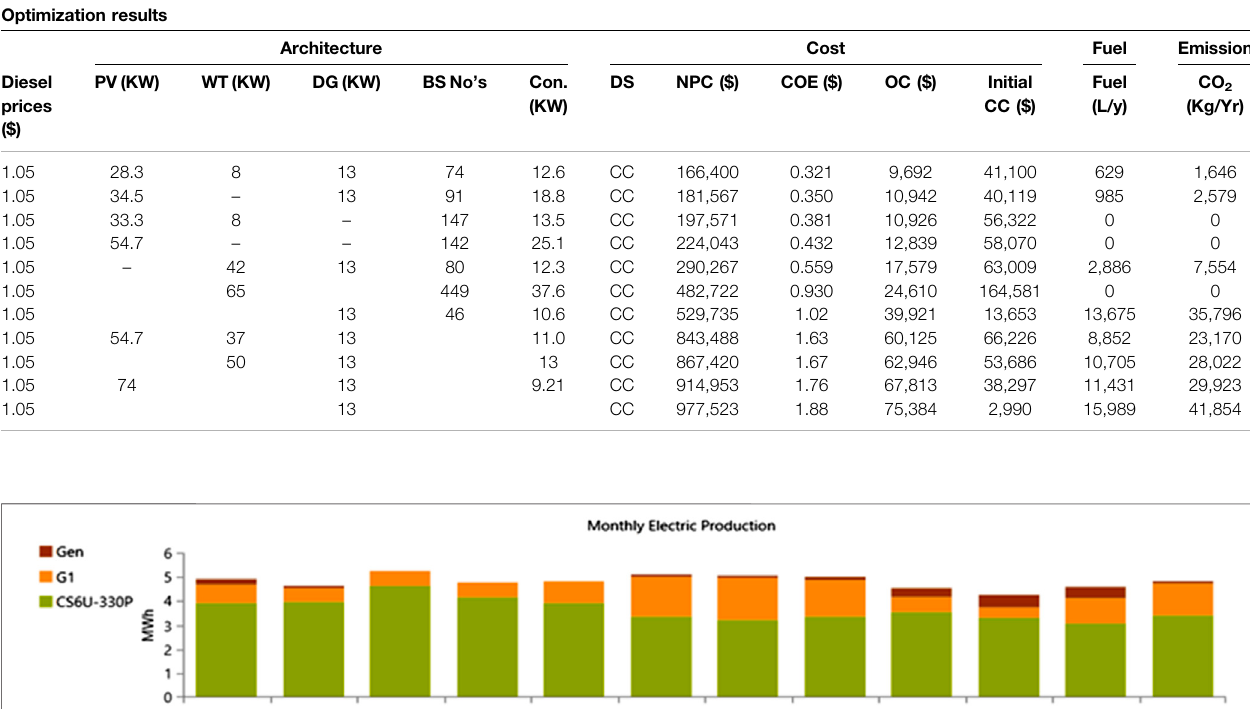
TABLE 7 | HOMER optimization results of the PV/Wind/Diesel/Battery system for the location Vellore. Optimization results